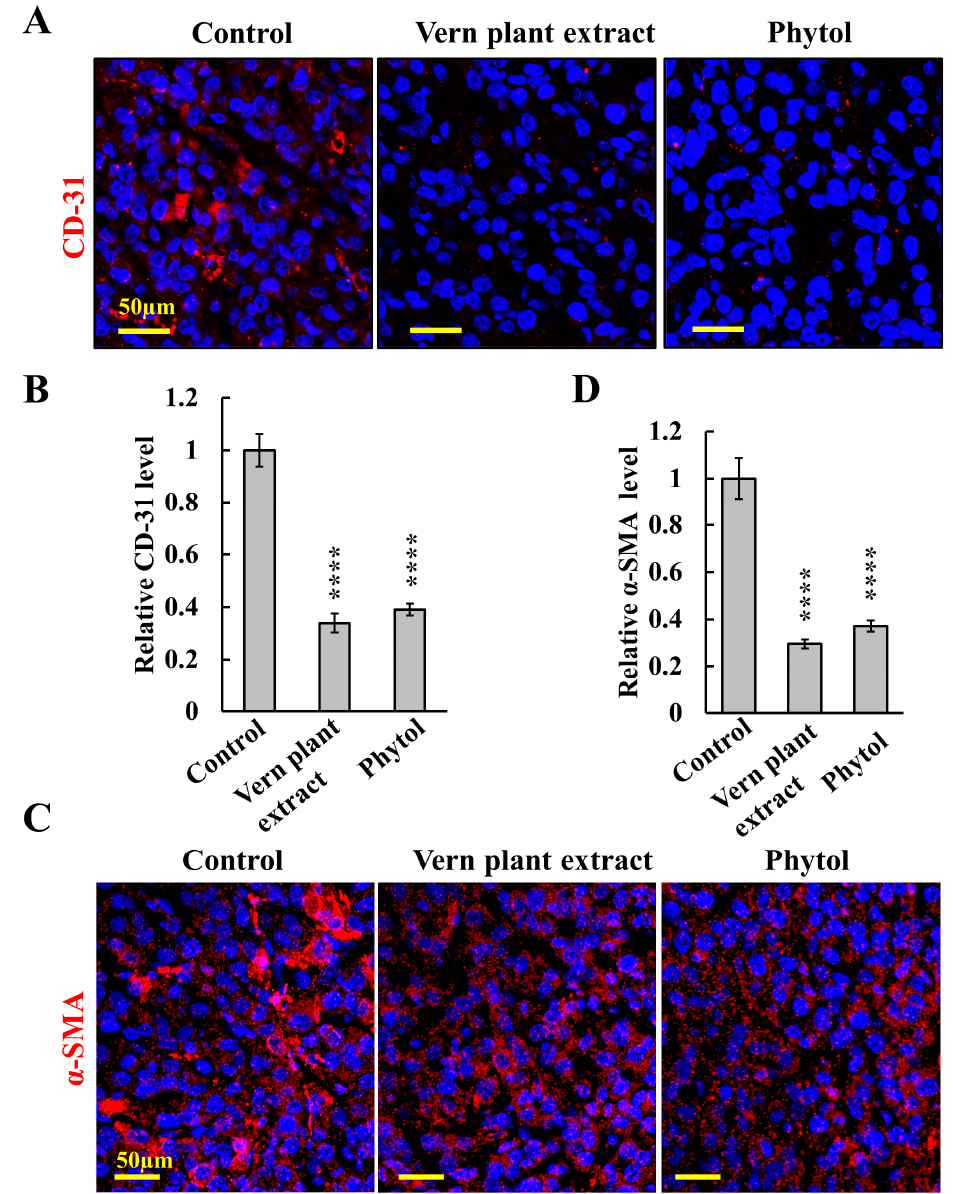
Figure 8. Vern plant extract and phytol treatment markedly reduced angiogenesis and the tumor microenvironment in U-87MG cell-derived tumors . Confocal images of sections from U-87MG-derived tumors, control or Vern plant extract (1:500) or phytol (75 μ M)-treated tumors were immunofluorescent-stained for CD-31 ( A , B ) or α -SMA ( C , D ), and their quantification is presented ( B , D ). Results are means ± SEM ( n = 3 mice), **** p ≤ 0.0001.